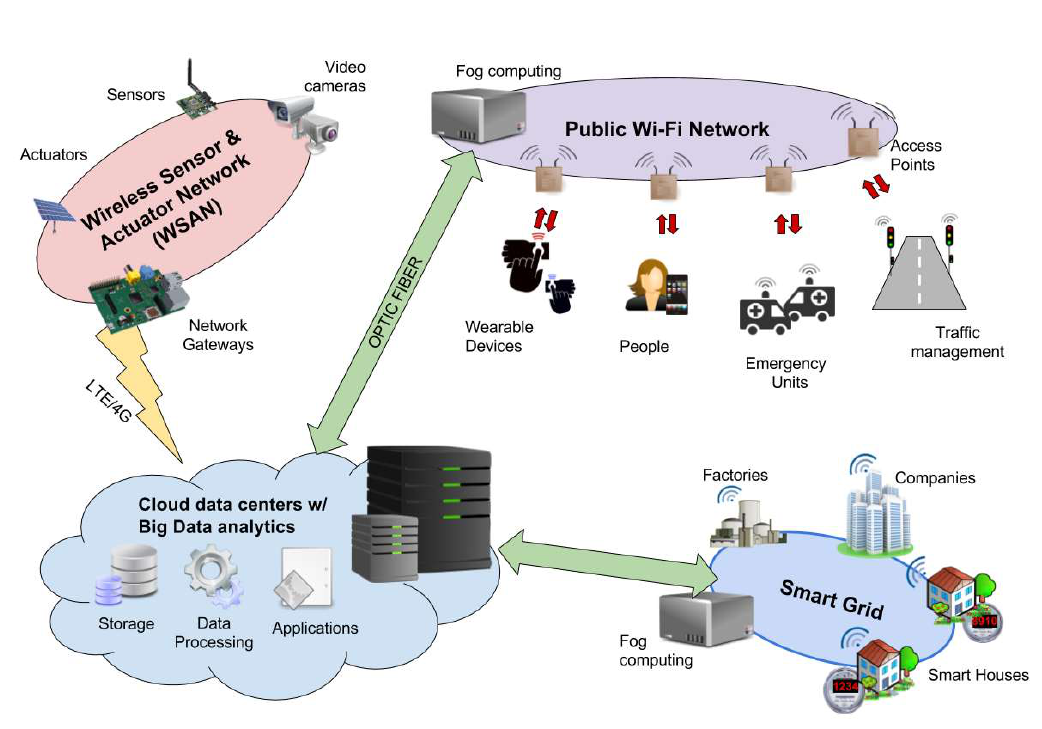
Figure 1. Typical architecture of a Smart